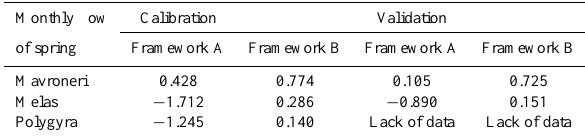
Table 2. Coefficients of efficiency between computed and ob- served monthly flows for the period of calibration (October 1984–